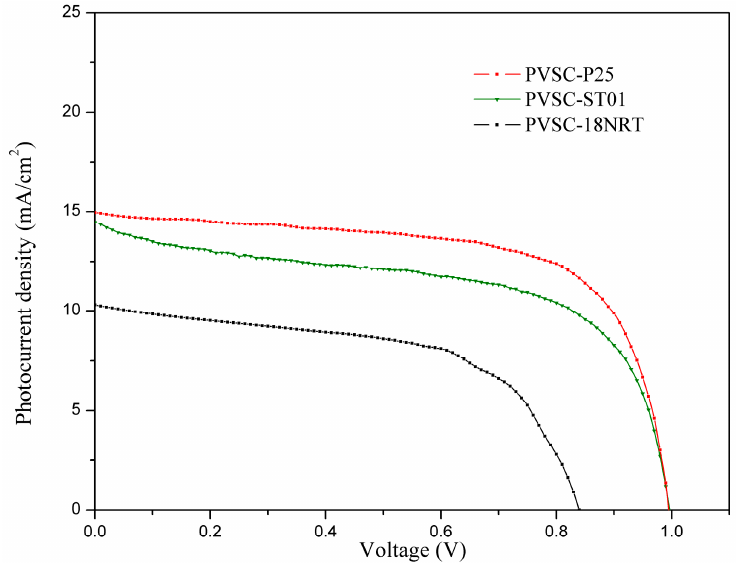
Figure 6. Photocurrent density-voltage curves of PVSCs incorporating various kinds of TiO 2 in the active layer.